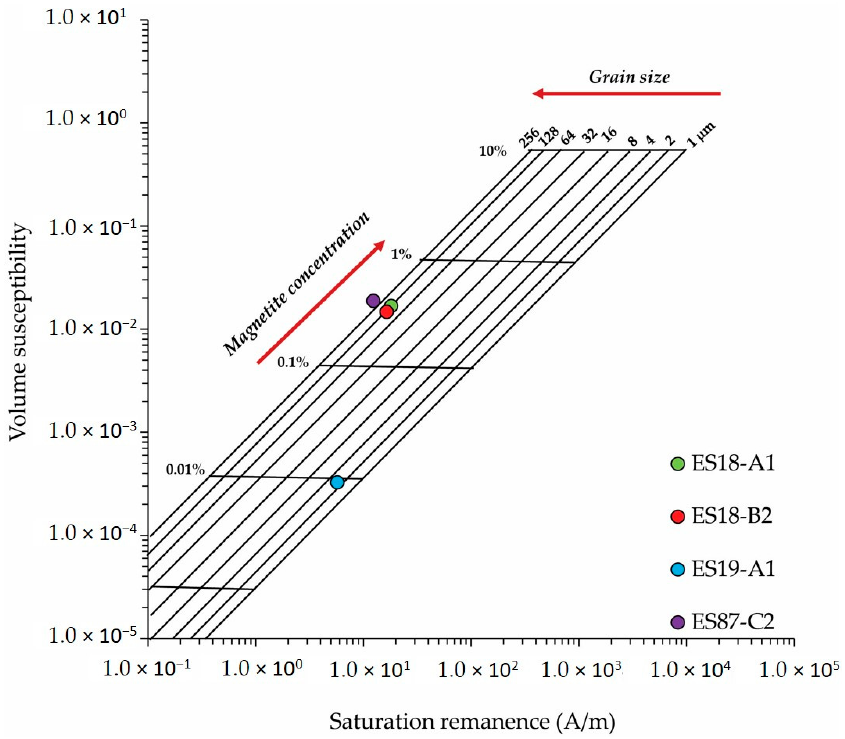
Figure 11. Bilogarithmic saturation remanence versus susceptibility